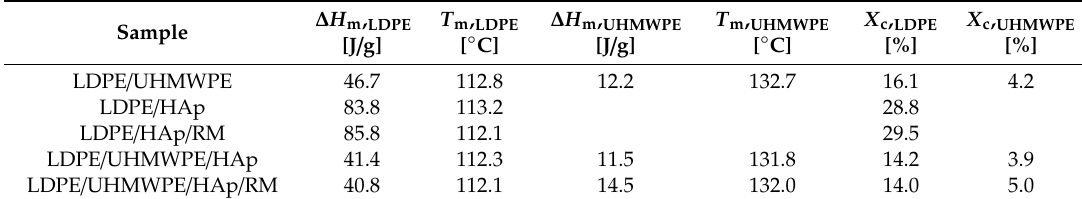
Table 4. Melting temperature ( T m ), enthalpy of melting ( ∆ H m ), crystallization temperature ( T c ), and degree of crystallinity ( X c ) for LDPE